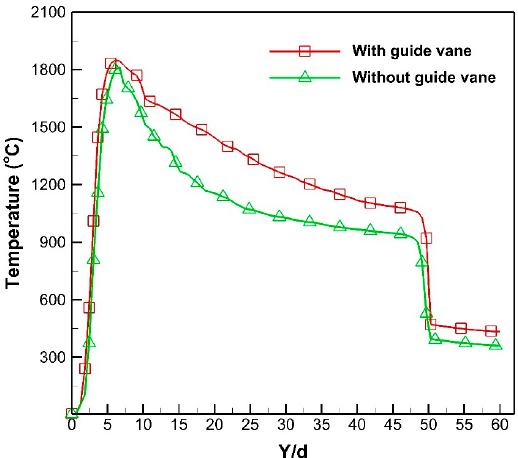
Figure 6. Comparison of the temperature distribution with and without the guide vanes as a function of Y/d.